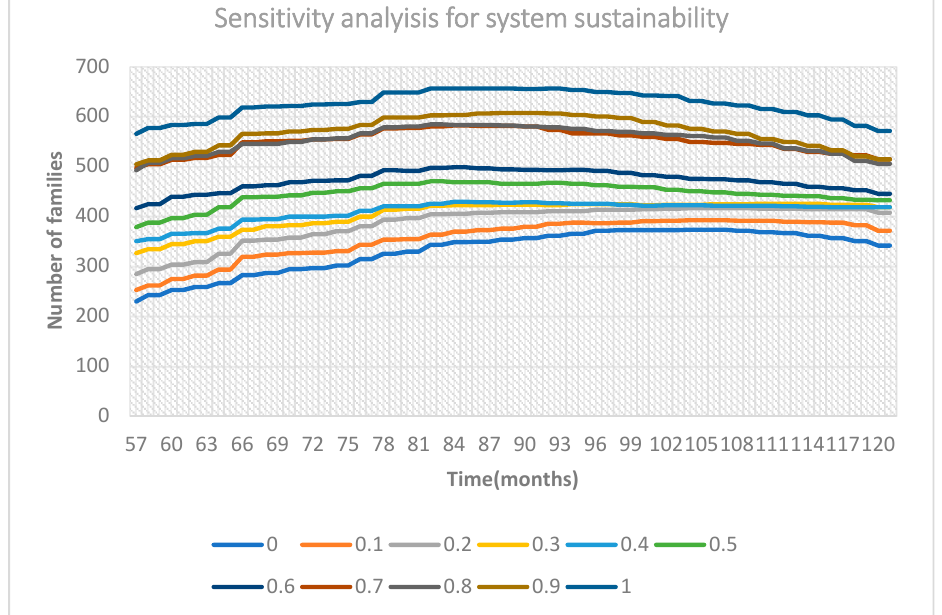
Figure 10. The effect of different weights of system sustainability on transformation outcomes.